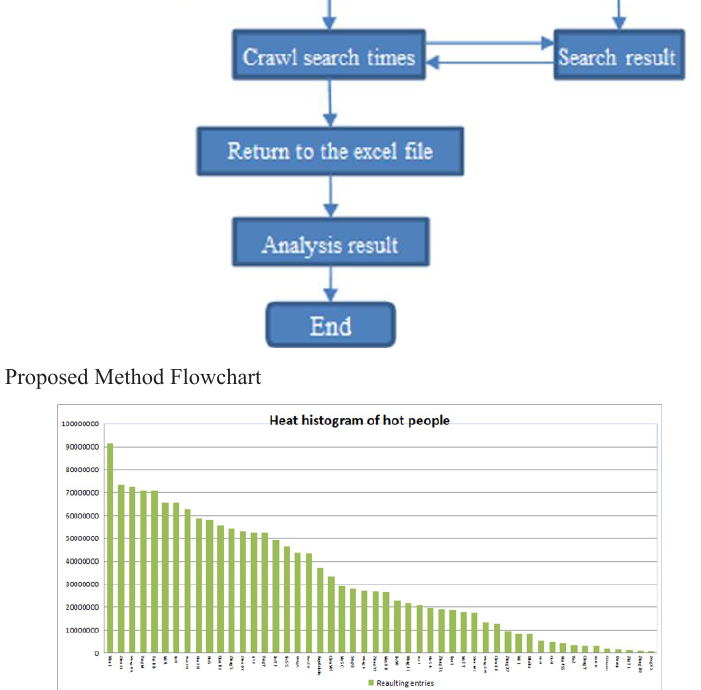
Fig. 1. Search Engine Workflow